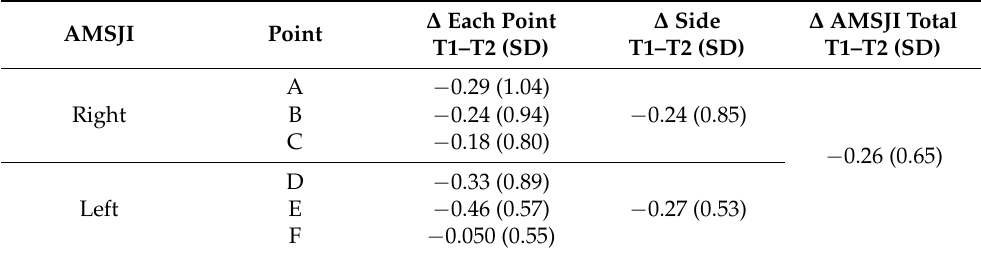
Table 1. Effect on the bony alveolar ridge perpendicular underneath the posts (in mm). A negative value indicates a mean resorption.